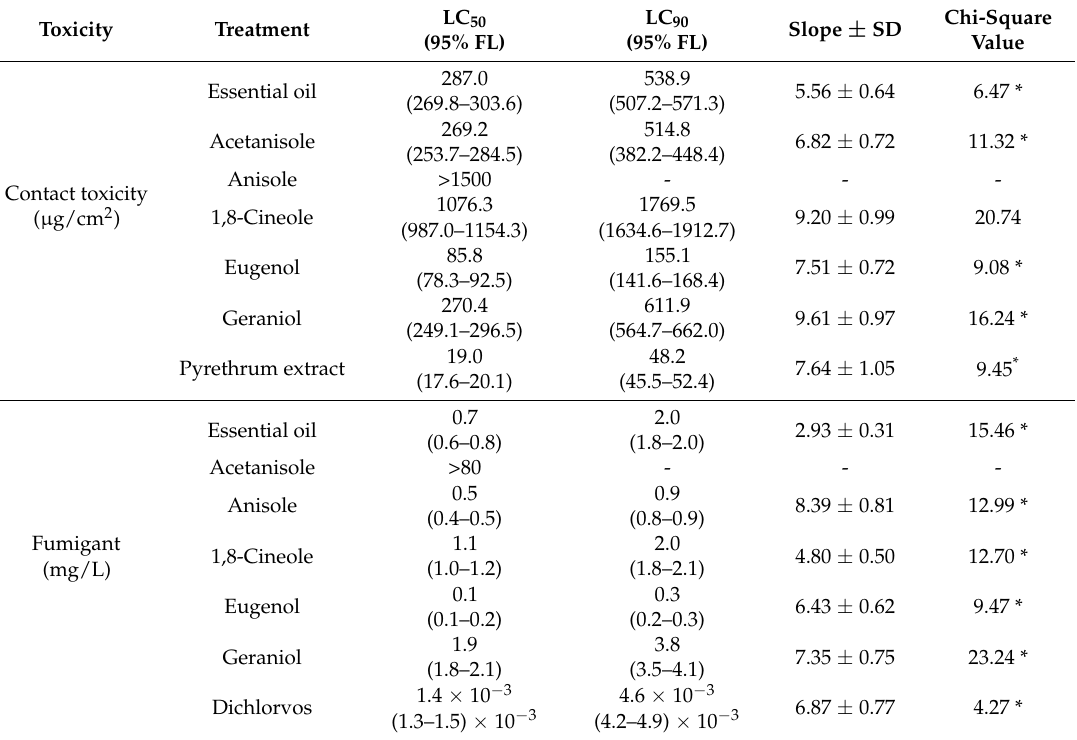
Table 2. Contact and fumigant toxicity of the essential oil of Stachys riederi var. japonica aerial parts against the adults of Liposcelis